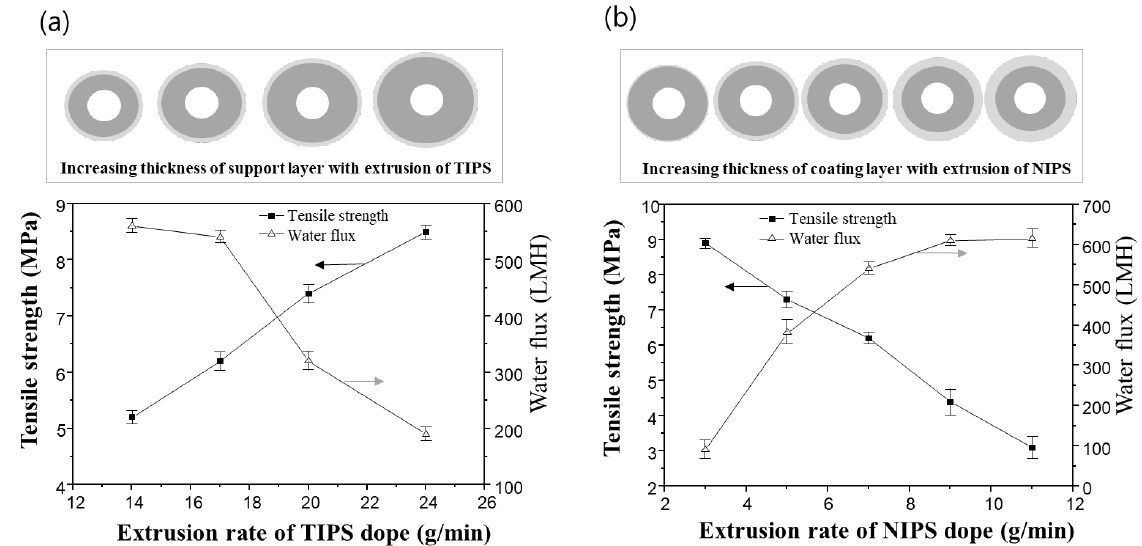
Figure 11. The tensile strength and water flux changes for sample #2N in the function of the extrusion rate of TIPS and NIPS dope, respectively: ( a ) the variation of tensile strength and water flux via TIPS extrusion rate. Fixed at NIPS extrusion rate 7 g/min and bore extrusion rate 6 g/min, and ( b ) the variation of tensile strength and water flux via NIPS extrusion rate. Fixed at TIPS extrusion rate 17 g/min and bore extrusion rate 6 g/min.